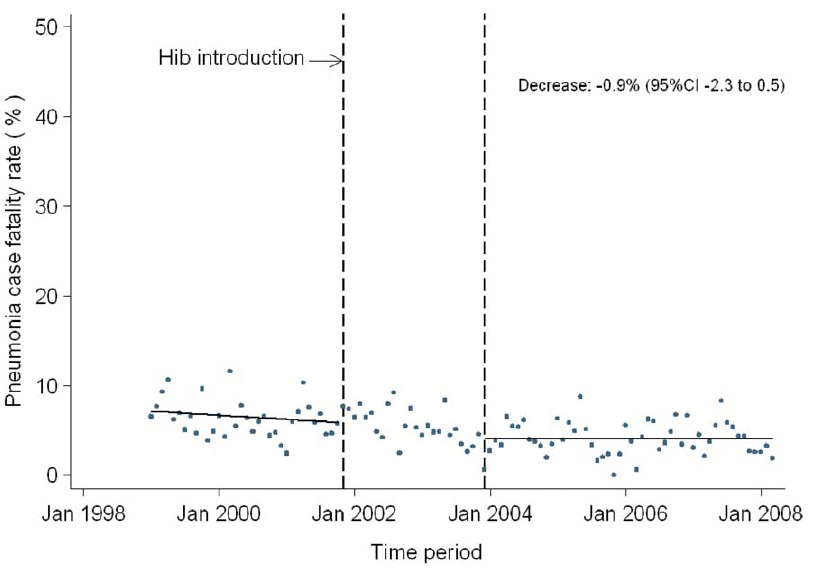
Figure 1. Interrupted time series analysis of pneumonia mortality among paediatric admissions to Kilifi District Hospital (1999 to 2008).